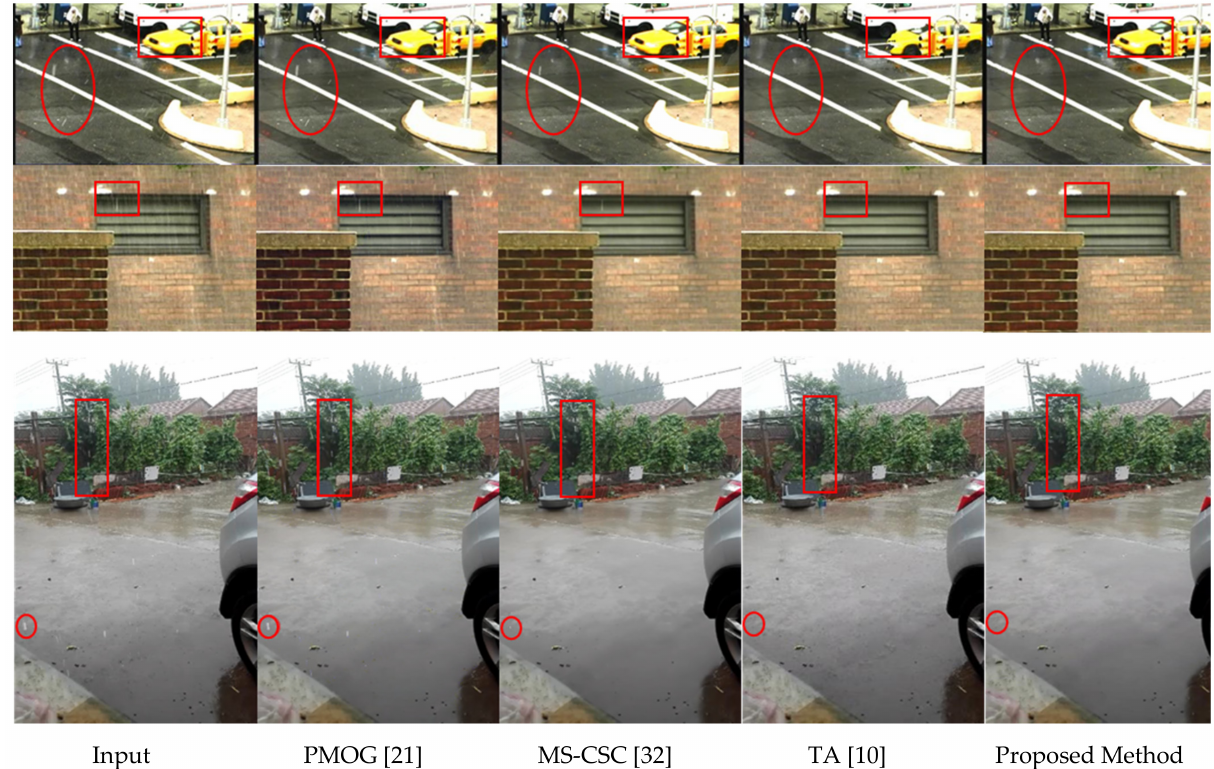
Figure 12. Comparison of the results of different methods (see the red circle and rectangle area closely) for the real-rain video sequences “Traffic” (1st row), “Wall” (2nd row), and “Yard” (3rd row),